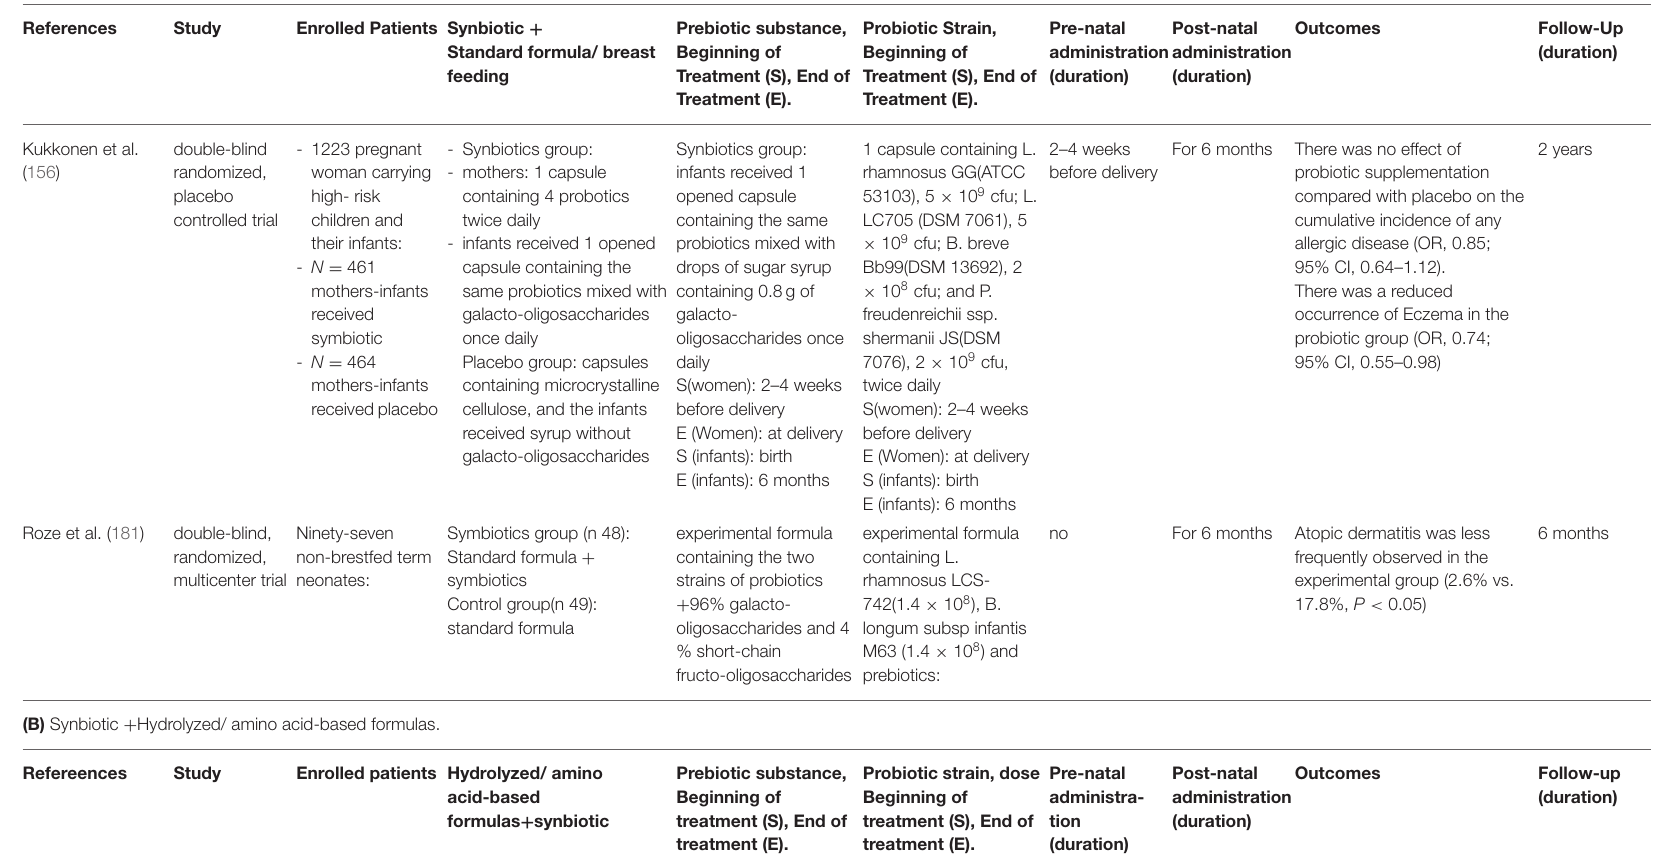
TABLE 3 | Synbiotics administration in prevention of allergic disorders. (A) Synbiotic + Standard